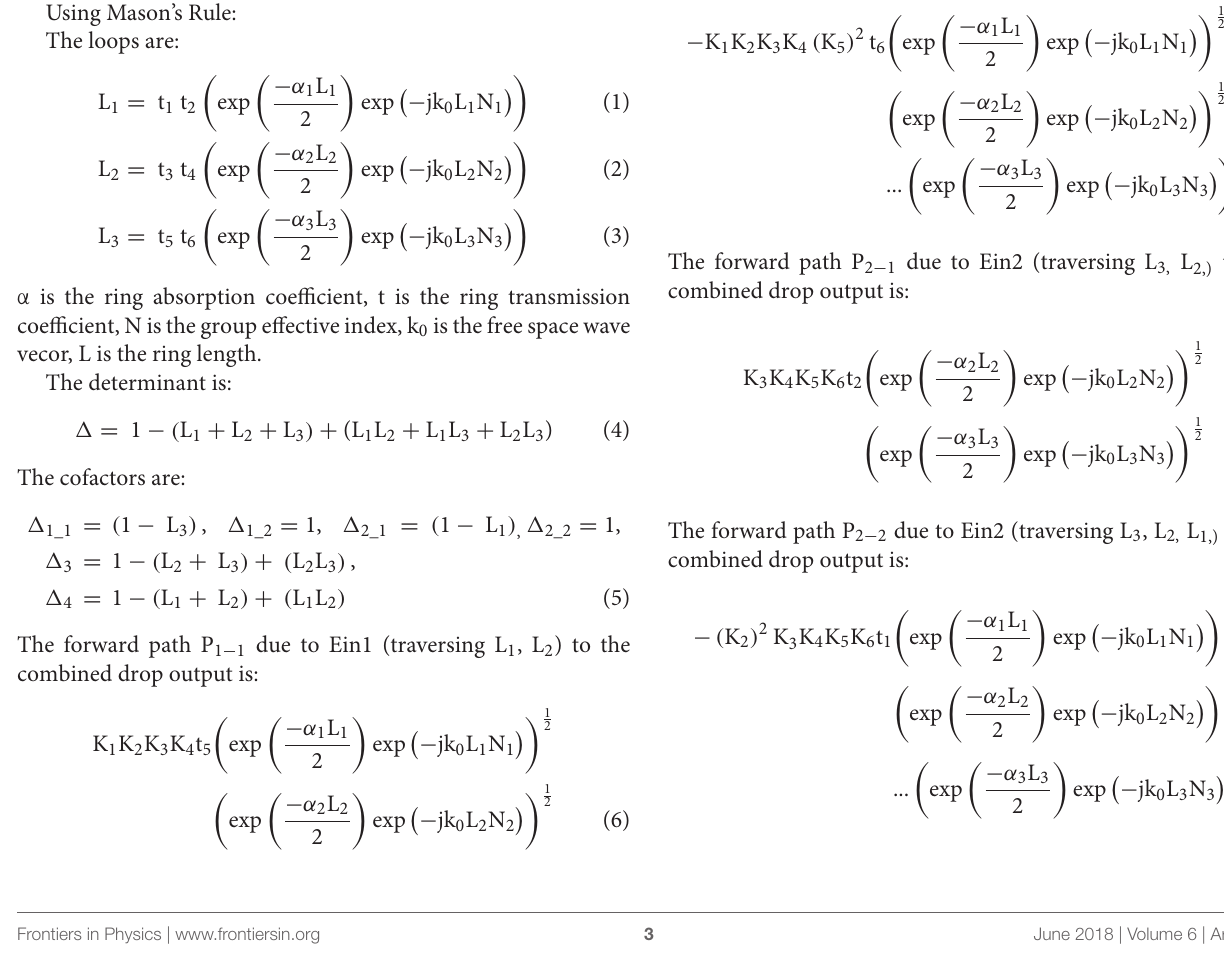
MATLAB program is processed as an intensity which provides the results for the MATLAB generated spectral outputs shown in Figure 3 , section Discussion and